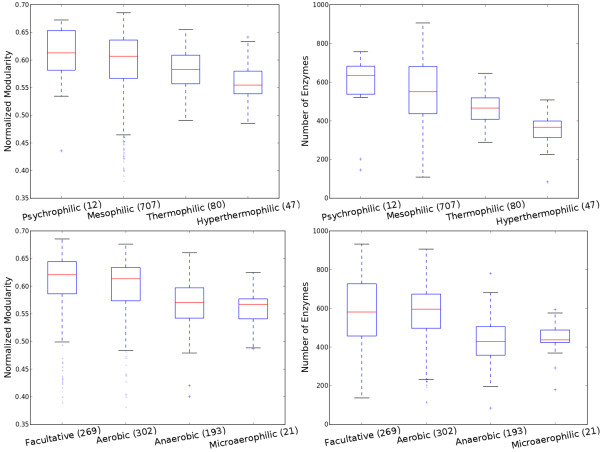
Modularity and environment factors. (Upper left) normalized modularity vs. oxygen requirement (Kruskal-Wallis H-test p = 2.96 × 10−25); (Upper right) number of enzymes vs. oxygen requirement (Kruskal-Wallis H-test p = 3.35 × 10−33); (Lower left) normalized modularity vs. temperature requirement (Kruskal-Wallis H-test p = 5.52 × 10−9); (Lower right) number of enzymes vs. temperature requirement (Kruskal-Wallis H-test p = 1.06 × 10−19).